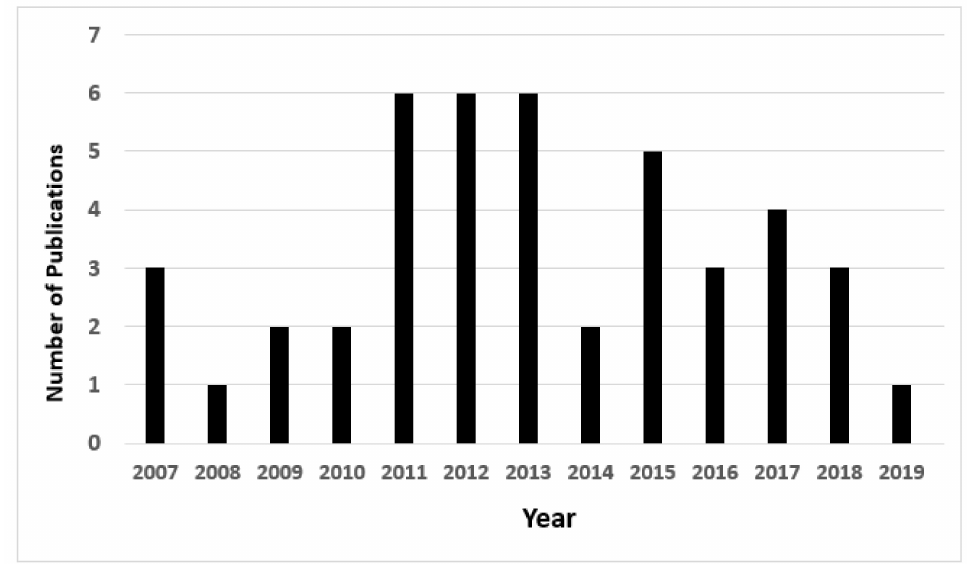
Figure 5. Number of selected articles published per year.